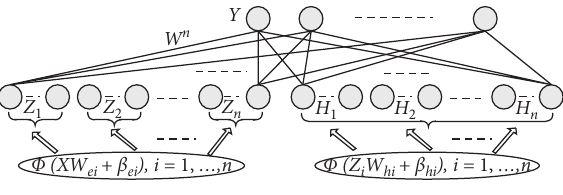
Figure 2: Structure of BLS.